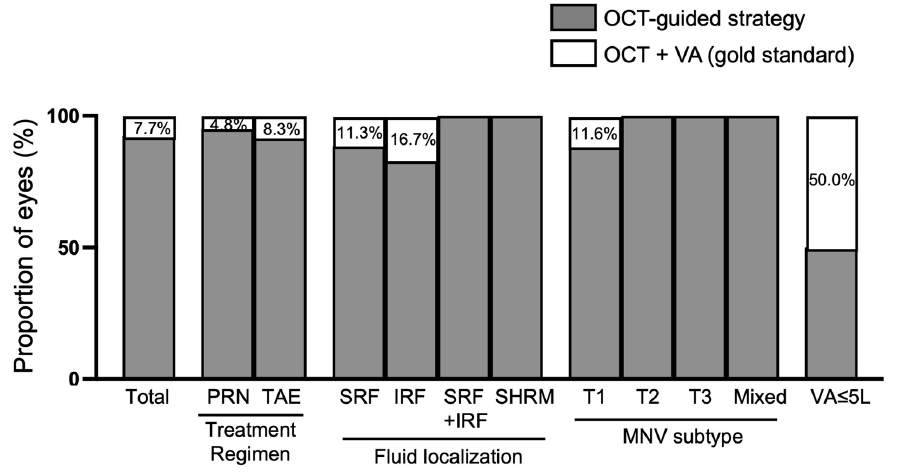
Figure 1. Performance of OCT-guided strategy for retreatment decisions in comparison to the gold standard (visual acuity + OCT). IRF: intraretinal fluid; MNV: macular neovascularization; OCT: optical coherence tomography; PRN: pro re nata; SHRM: subretinal hyperreflective material; SRF: subretinal fluid; TAE: treat and extend; T1-T2-T3: type 1-2-3; VA: visual acuity. In the whole population, the OCT-guided strategy had a sensitivity of 94.0% (95%CI (86.2–97.7)) and specificity of 89.8% (95%CI (79.2–95.5)); the corresponding PPV and NPV